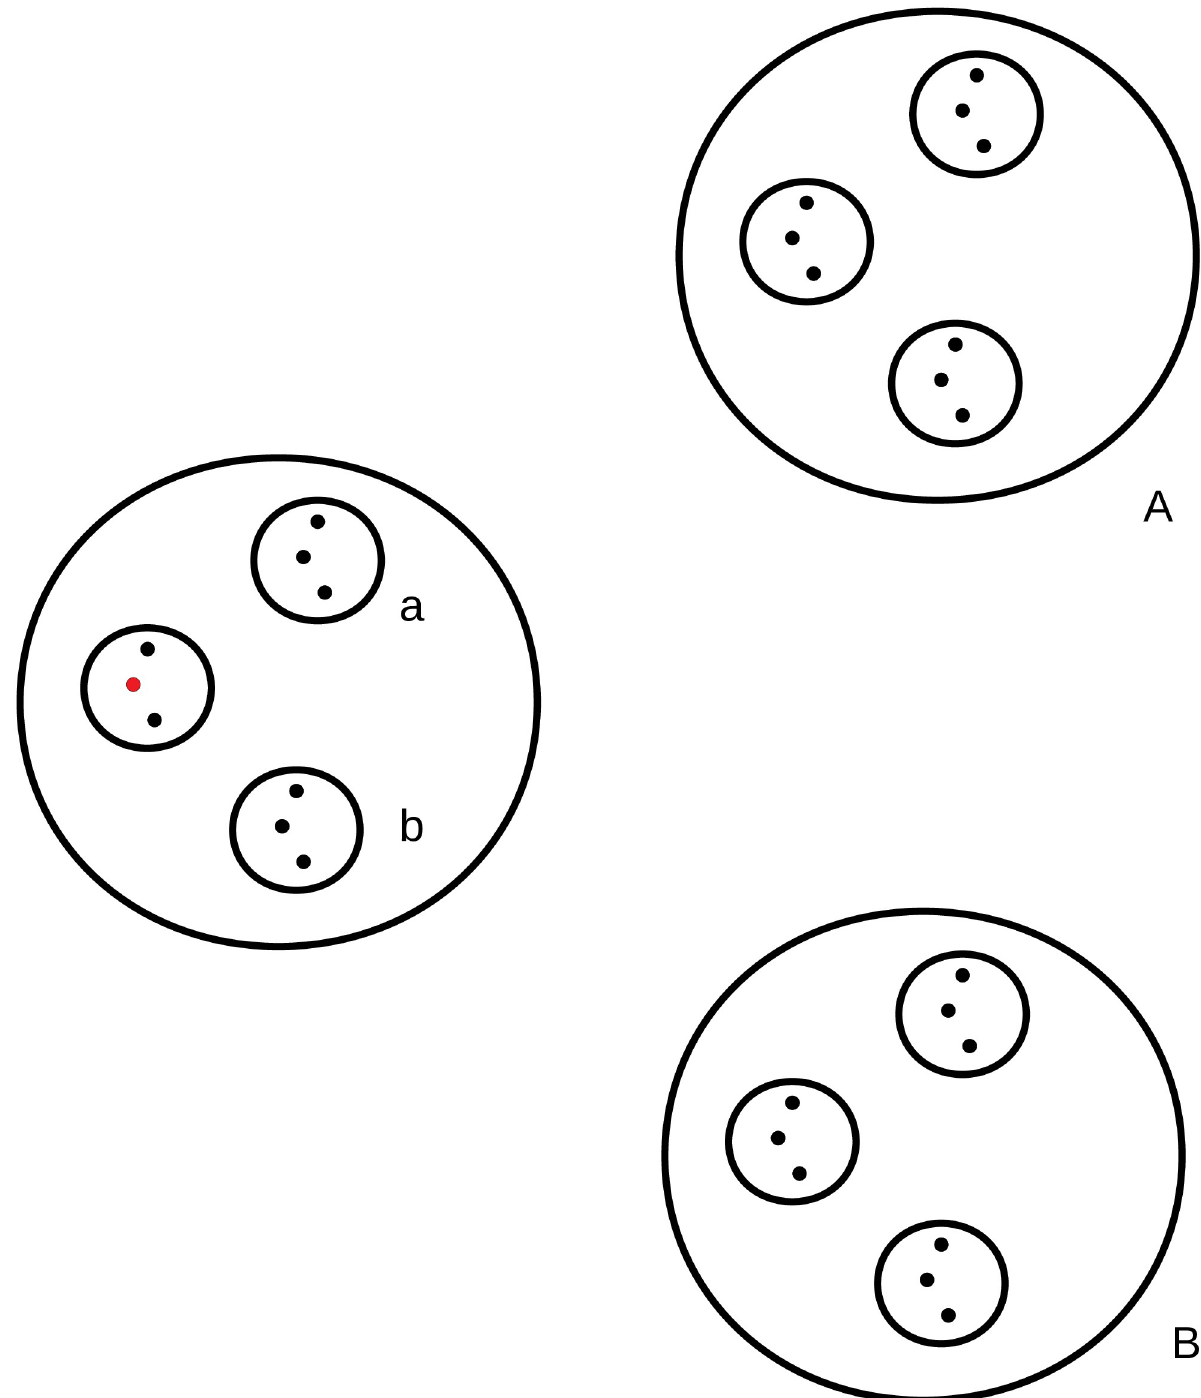
Fig 1. Schematic view of the fractal network. The individual represented by a red circle seeds the spread of information in the close contact group, or agent, represented by the smallest circle in which the individual is included. The spreading of information among larger groups, as indicated by letters a and b, scales according to the renormalization property of the fractal network. The same applies to still larger groups, as A and B.